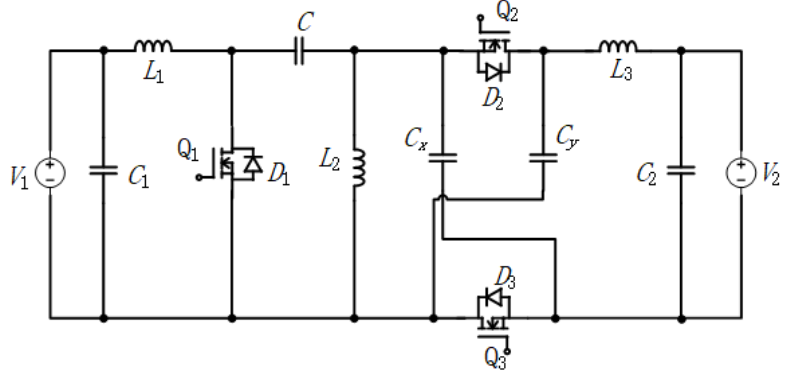
Figure 8. A non-isolated bidirectional DC-DC converter in [12]. Table 1. Voltage gain and other features in select converters.